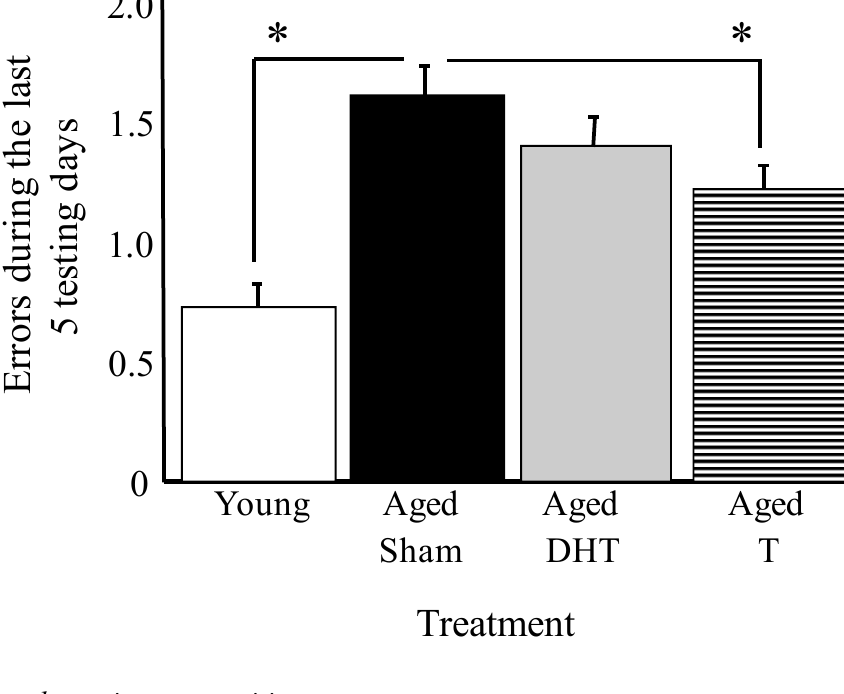
Figure 7. Testosterone supplementation decreased spatial working memory errors in aged male gonadally intact rats [215]. Rats were not castrated in this study in an attempt to conserve the hypothalamic/pituitary/gonadal axis, as this axis is typically conserved in older men. The administered androgen treatments were thus supplemental therapies. The aged male rats were divided into three treatment groups (n = 11 per group): sham (Aged Sham), dihydrotestosterone (Aged DHT), testosterone (Aged T). There was also a young male group which received sham surgery. Aged sham rats made more mean ± SE spatial working memory errors than young sham rats, and aged rats treated with testosterone (Aged T) committed fewer spatial working memory errors than aged rats receiving vehicle treatment (Aged Sham). * p < 0.05, *** p <